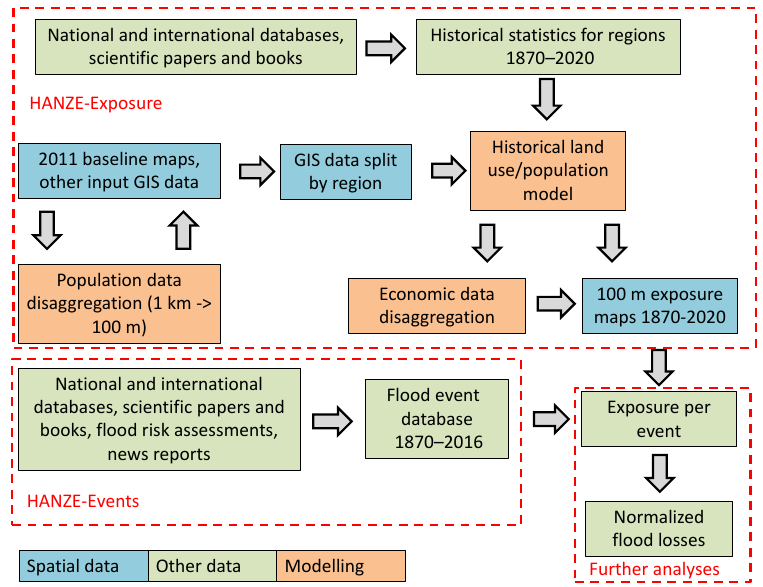
Figure 1. Workflow of the HANZE database from input data sets to final exposure maps and flood events database, and an example of how the two components interact to derive normalized flood